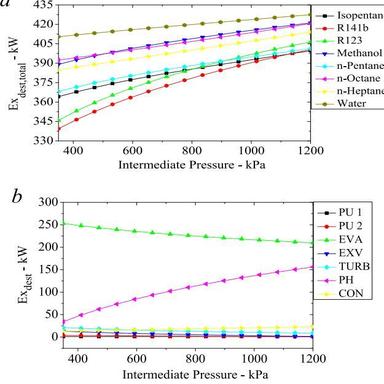
Total exergy rate as a function of intermediate pressure for different working fluids (a) exergy-destruction of the ORC-CHP components in total exergy-destruction (b) (R141.